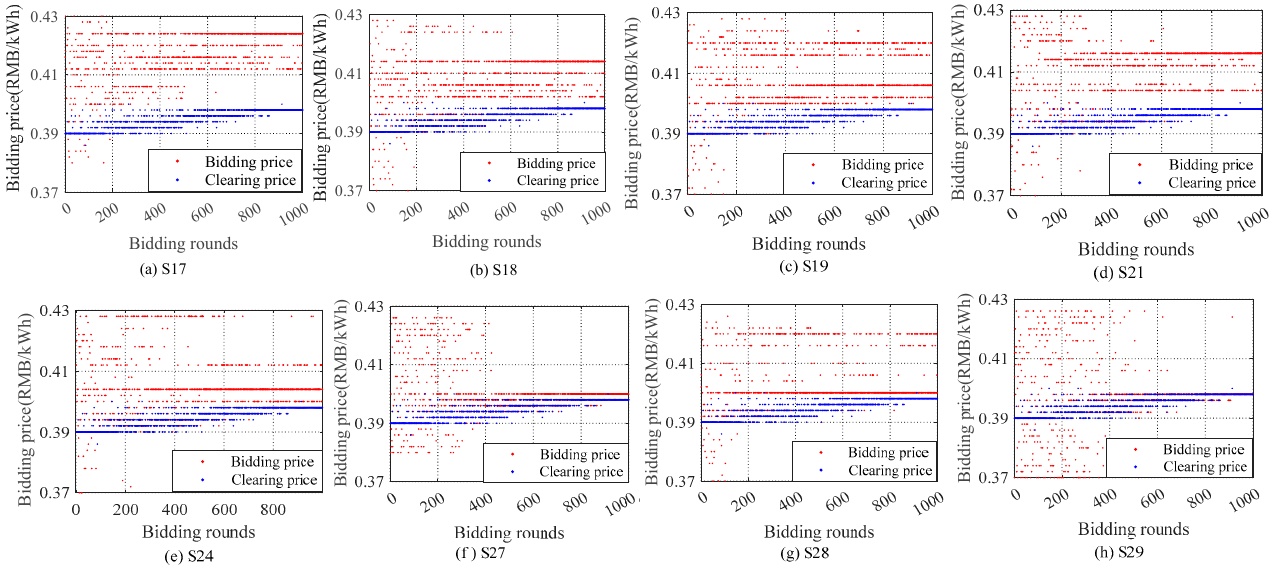
Figure 7. Bidding prices of power retail companies.